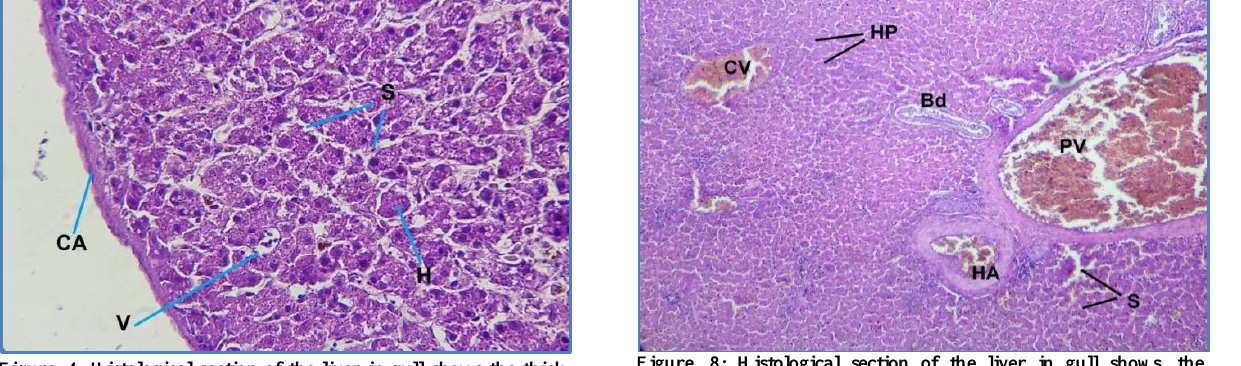
Figure, 4: Histological section of the liver in gull shows the thick capsule (CA), hepatocyte (H), sinusoids (S), vein (V) (H and E 20X).